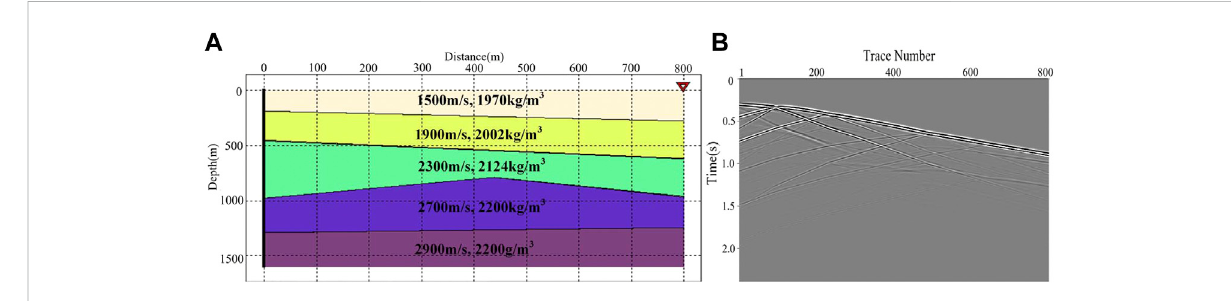
FIGURE 2 The forward model and corresponding synthetic DAS record: (A) the forward model, and (B) the synthetic DAS data.